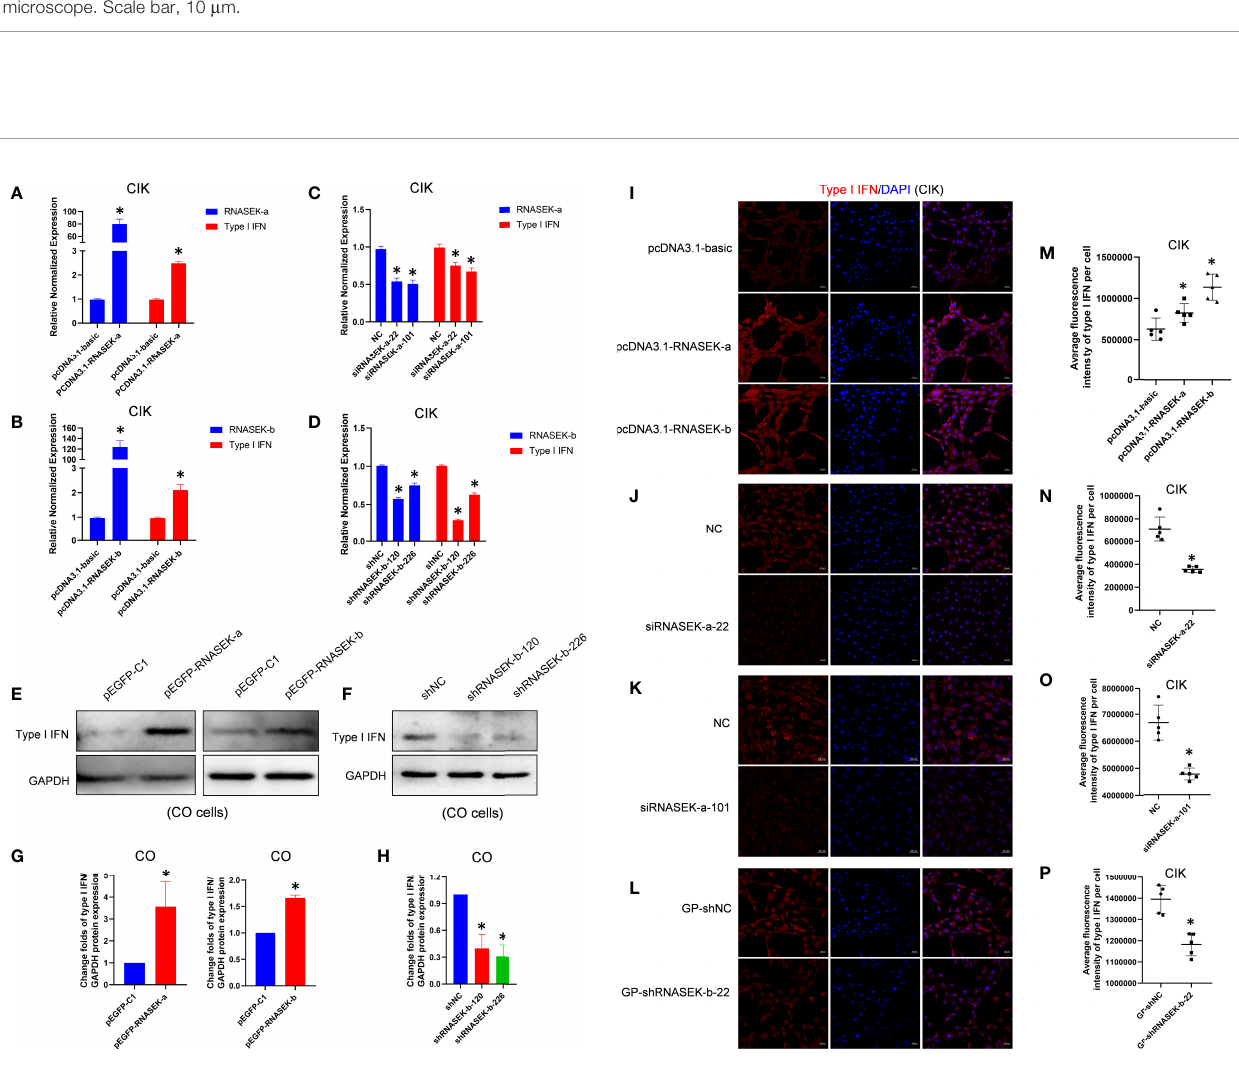
FIGURE 2 | Subcellular localization of RNASEK-a and -b within CIK cells. (A, B) Both GFP-tags of RNASEK-a (A) and -b (B) were exclusively expressed in the cytoplasm (green, GFP; blue, DAPI). (C) RNASEK-a and -b were colocalized with each other (red, p3×Flag-RNASEK-a; green, pEGFP-RNASEK-b; blue, DAPI; yellow, colocalization). (D, E) RNASEK-a was colocalized with early endosome marker Rab5 (D) and late endosome marker Rab7 (E) in the cytoplasm (green, pEGFP-RNASEK-a; red, pDsRed-Rab5 and -Rab7; blue, DAPI; yellow, colocalization). (F, G) RNASEK-a was rarely colocalized with the mitochondria (F) and lysosomes (G) in the cells (green, pEGFP-RNASEK-a; red, mitochondria indicated by MitoTracker and lysosomes traced by Lyso-Tracker; blue, DAPI or Hoechst; yellow, colocalization). (H) RNASEK-a was in part localized to the endoplasmic reticulum (green, pEGFP-RNASEK-a; red, endoplasmic reticulum traced by ER-Tracker; blue, DAPI; yellow, colocalization). (I – M) Subcellular localization of RNASEK-b was the same as that of RNASEK-a (D – H) . Experiments were performed by transfection of only one kind of recombinant plasmid for one protein localization or two different ones for colocalization. The results are